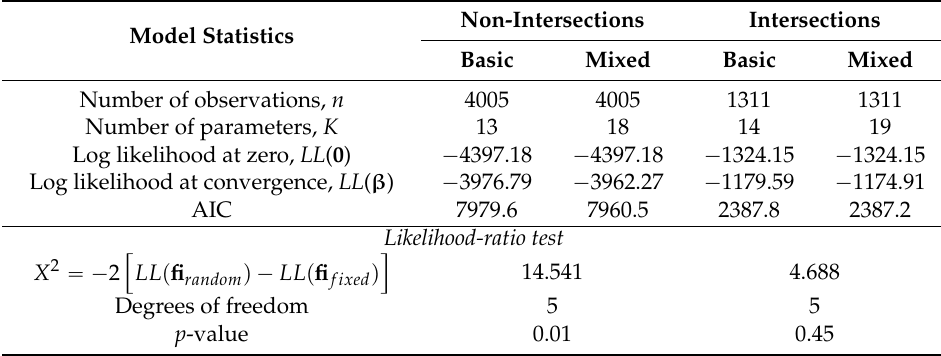
Table 2. Goodness-of-fit measures for basic and mixed ordered logit